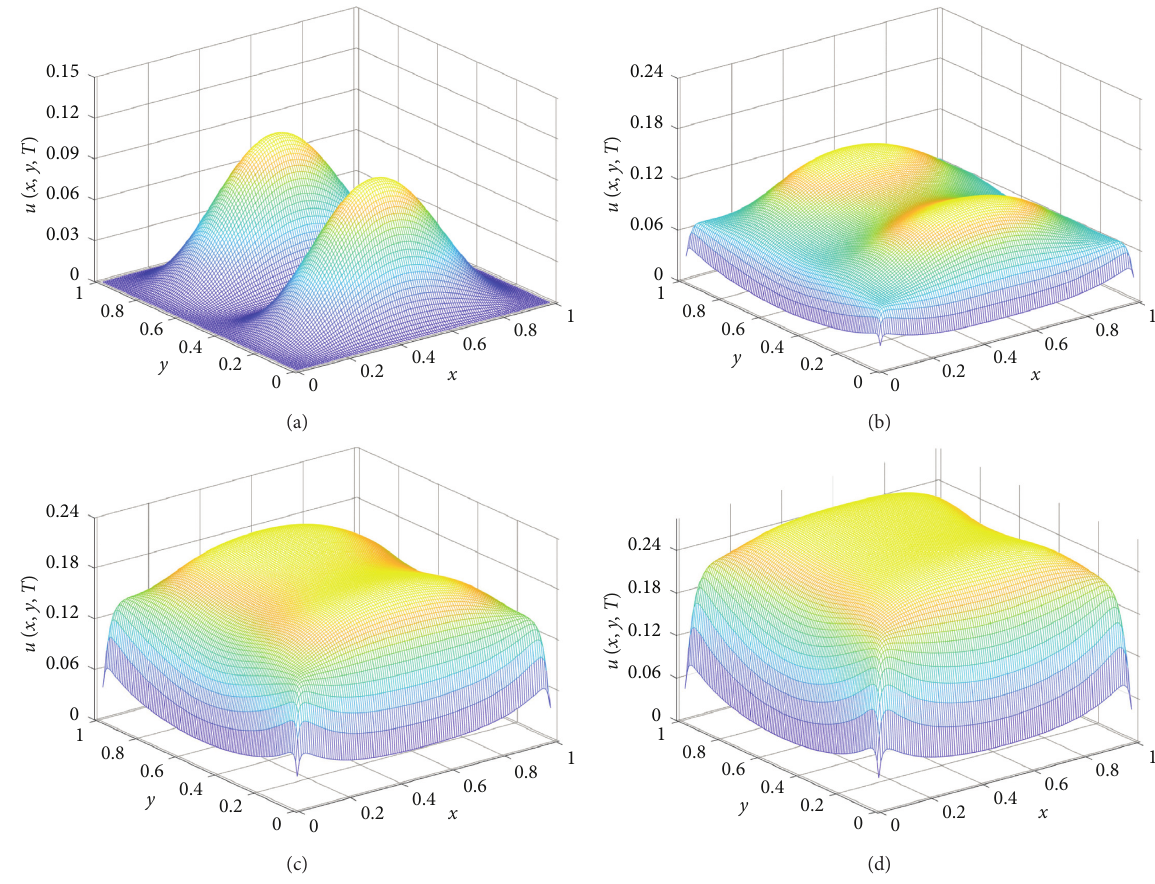
Figure 1: Numerical solution u ( x,y, T ) at T � 2 τ ≈ 1 . 36602691 × 10 − 5 (a); T � 10 , 000 τ ≈ 0 . 06830134 (b); T � 20 , 000 τ ≈ 0 . 13660269 (c); and T � 30 , 000 τ ≈ 0 . 20490403 (d). The corresponding maximal values are 0.09996733, 0.13774652, 0.20421692, and 0.28487089,